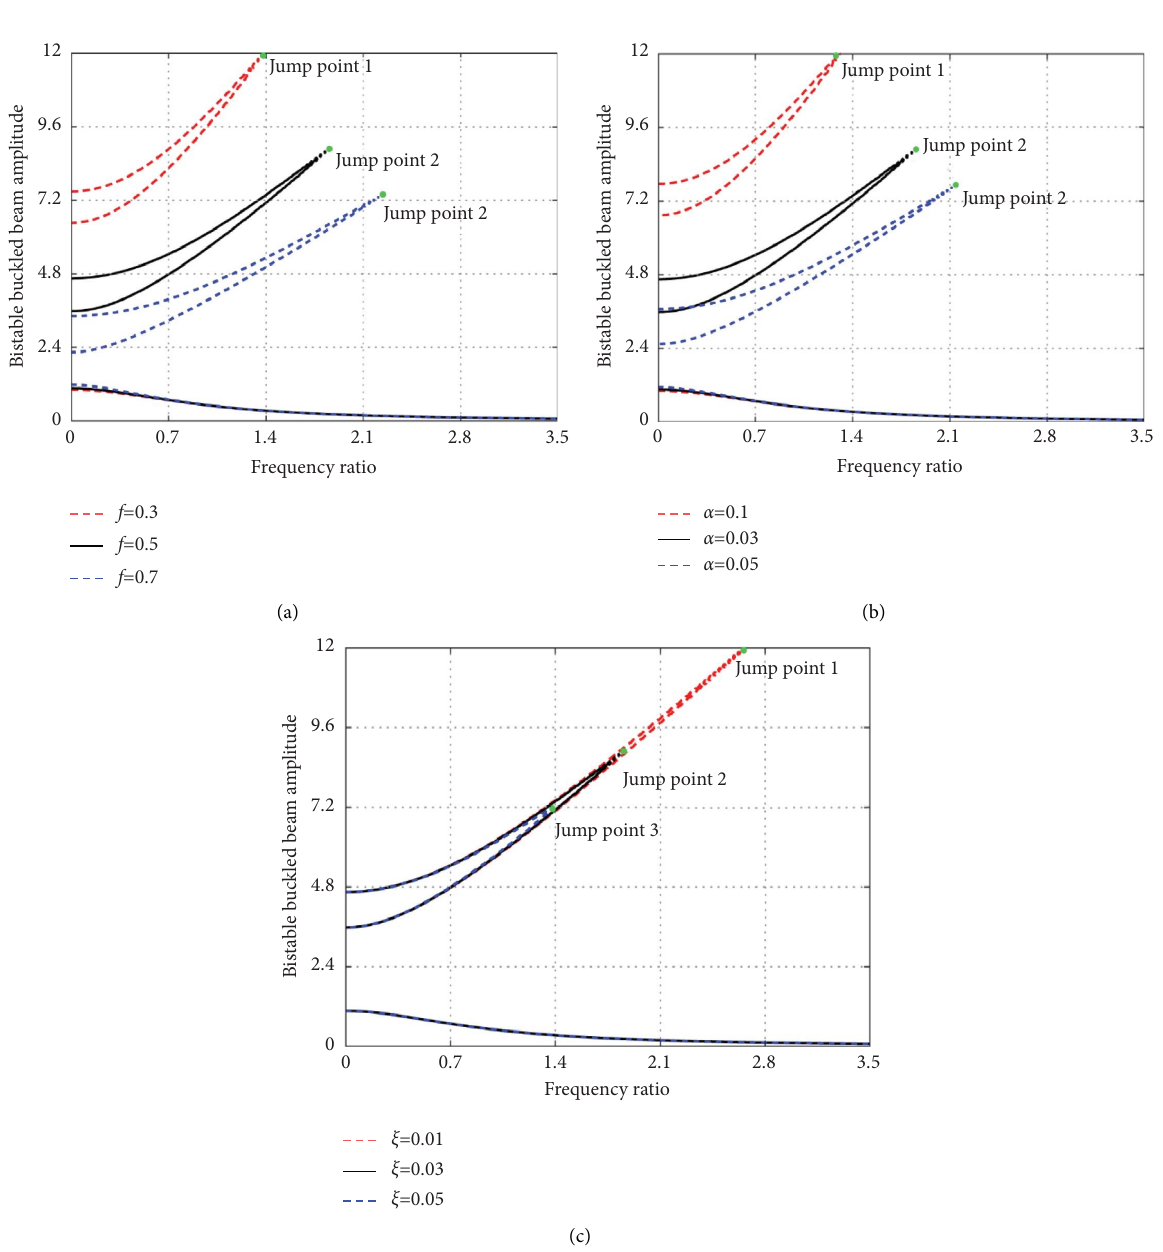
Figure 5: Te amplitude-frequency response curve of the buckled